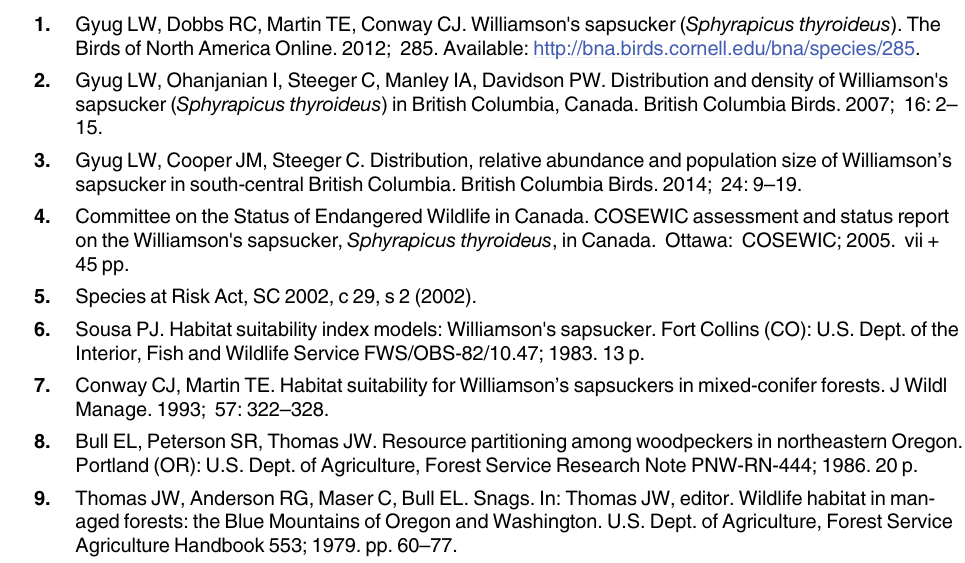
S1 Table. Habitat variables (211 variables) considered in the construction of Williamson ’ s sapsucker nest territory selection models, prior to variable reduction. All GIS variables are repeated for the 225 m, 400 m and 800 m scales, with the exceptions of